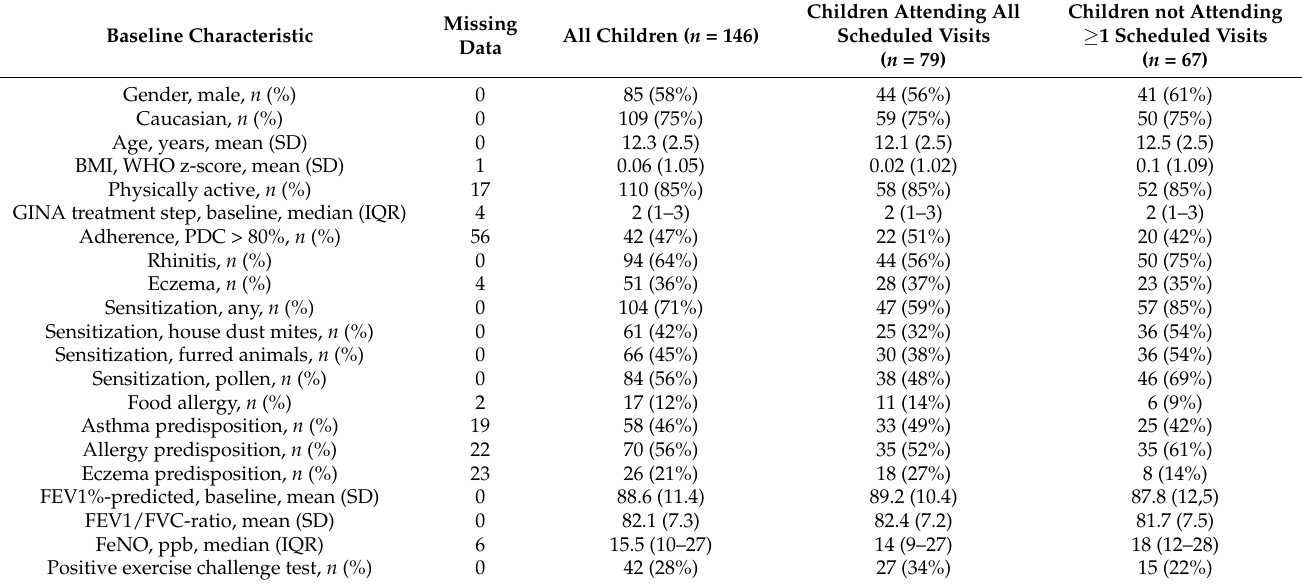
Missing All Children ( n = 146) Data